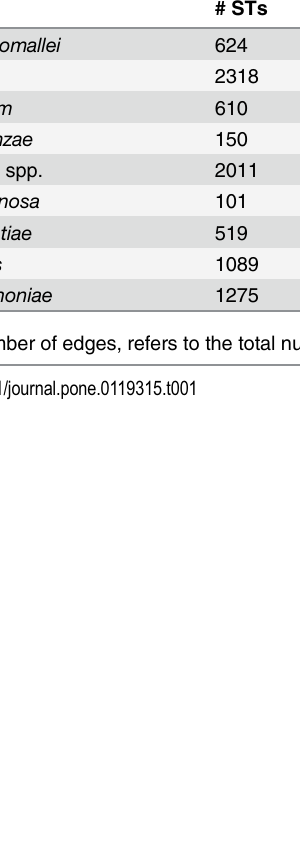
Table 2. The effect of goeBURST tiebreaking rules in reducing MST space. Each column represents the number of possible MSTs after each break rule. Data sets # Trees in the largest CC a Species All edges b